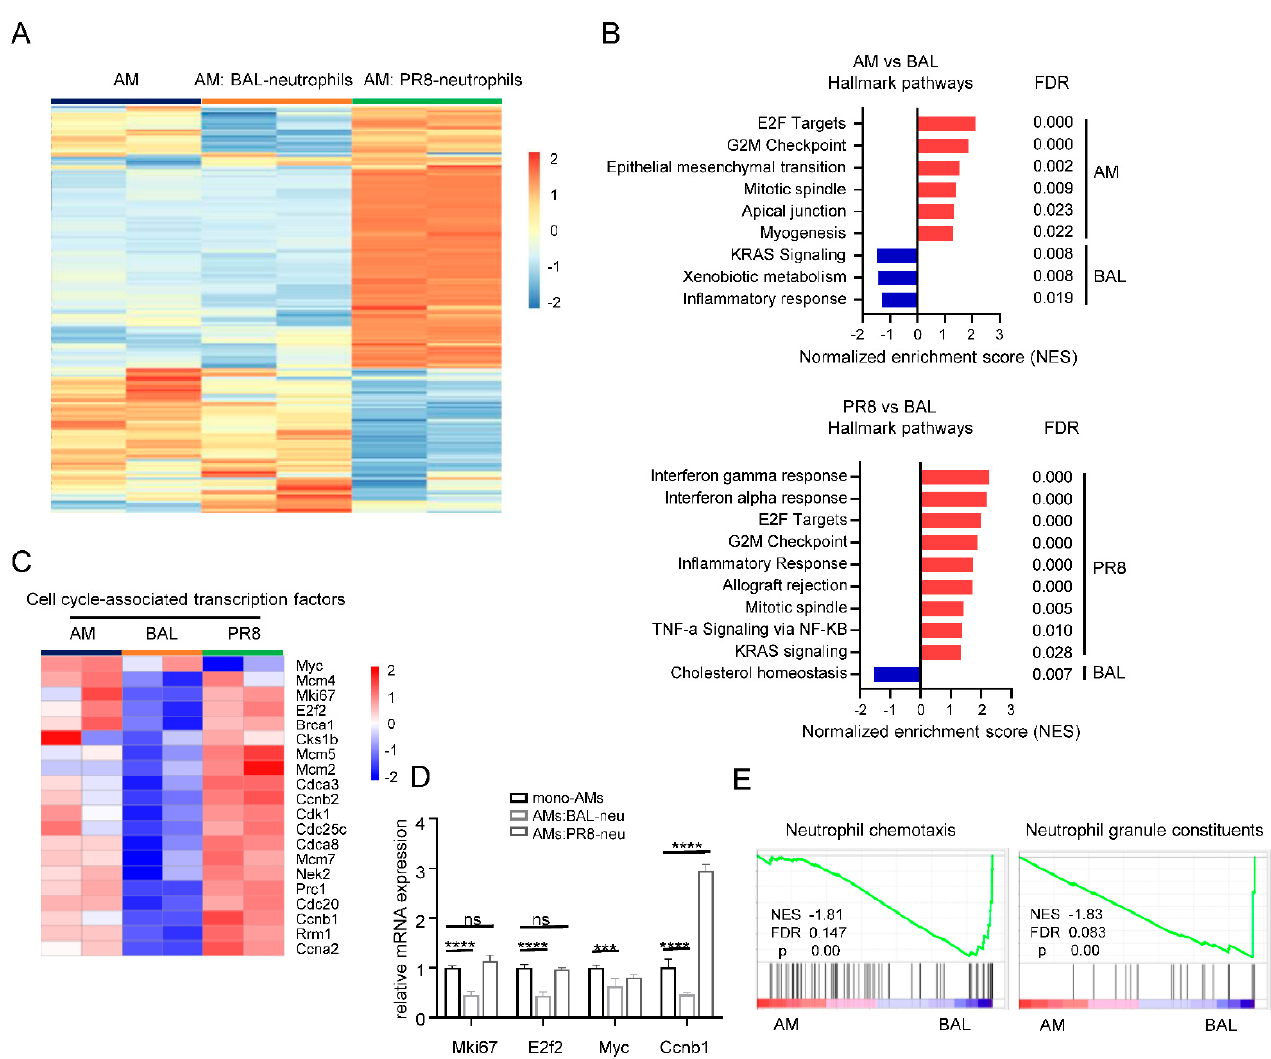
Figure 4. BAL–Neutrophils control AM maintenance. Differentially expressed genes were deter- mined by bulk RNA sequencing of AMs from AMs (alone), AM: BAL–neutrophils (co-culture of AMs and BAL–neutrophils, BAL group), and AM: PR8–neutrophils (co-culture of AMs and PR8– neutrophils, PR8 group) (1:1 ratio). ( A ) Heatmap showing top differentially expressed genes in the three groups. ( B ) GSEA from the hallmark gene sets in the molecular signatures database showing the significantly enriched gene sets between AMs (alone) and AMs of BAL groups, or AMs of PR8 and AMs of BAL groups. ( C ) Heatmap showing differentially expressed genes associated with cell cycle − associated transcription factors from AMs in AMs (alone), AMs of BAL, and AMs of PR8 groups. ( D ) The mRNA of Mki67, E2f2, Myc, and Ccnb1 of AMs from AMs (alone), AM: BAL–neu- trophils (AMs: BAL–neu), and AM: PR8–neutrophils (AMs: PR8–neu). ( E ) Enrichment plot from GSEA of infected neutrophils using gene sets for neutrophil chemotaxis and granule constituents between AMs (alone) and AMs of BAL groups. Data are presented as arithmetic mean ± SD. ns, no